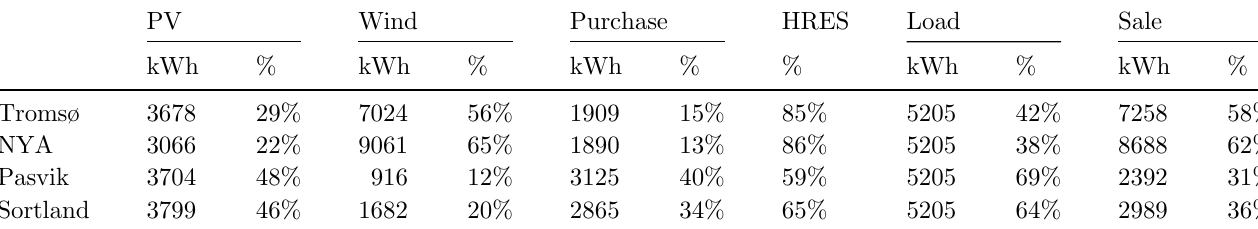
Table 3. The performance of the HRES based on meteorological data from 2001. Values are given in kWh and percentage share of each source in the system. PV, wind and purchases from the grid are the power input. The power delivered by the HRES is also given as a percentage share of the total power input. The load and sales are the consumption and the energy given back to the